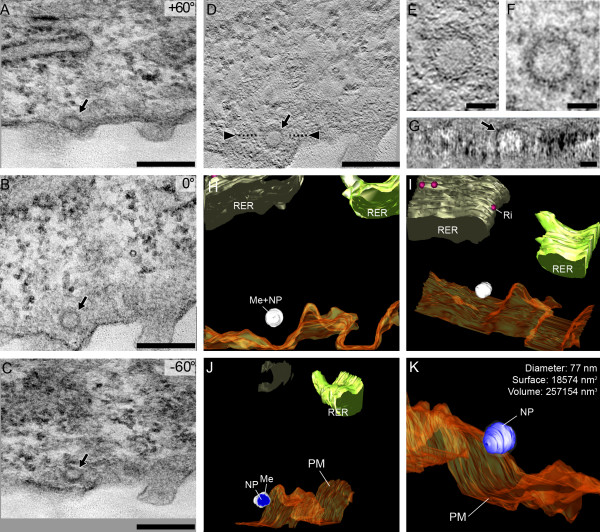
Electron tomography of a 250 nm thick section. A tilt series (three stills are shown in A, B and C) between +/- 60° with an increment of 1° provides the information for a volume reconstruction by weighted backprojection (D) of an in vitro grown alveolar epithelial cell (cell line A549), exposed to polystyrene NP prior to chemical fixation. The 2 nm thin slice (E, at a depth of 58 nm in the section) reveals a crisper and clearer depiction of the polystyrene NP than the 250 nm thick Epon section (F). Arbitrary digital slices can be made (G, position shown by the two arrowheads in D) in order to provide unquestionable recognition of the NP. Bars = 250 nm in A-D, 50 nm in E-G. Software based 3D rendering offers a way for segmentation according to the interpretation of the user and allows full perspective freedom (H and I). Moreover, clipping planes can partially dissect the scene (J), segmented objects can be omitted (the membrane surrounding the NP in K) and specific quantitative information on rendered objects obtained. Blue: nanoparticle, shades of green: rough endoplasmic reticulum (RER), orange: plasma membrane, transparent white: membrane surrounding the NP, red: ribosomes (Ri) on the RER. Me = membrane, NP = nanoparticle, PM = plasma membrane.